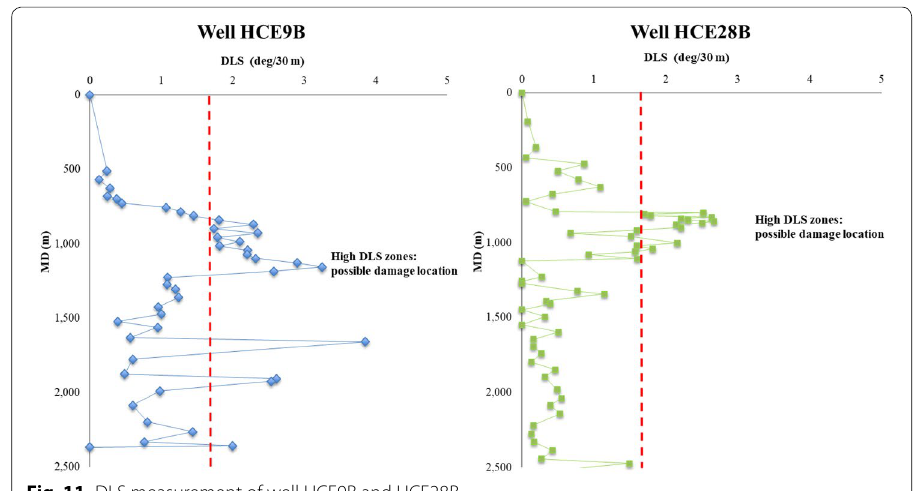
Fig. 11 DLS measurement of well HCE9B and HCE28B